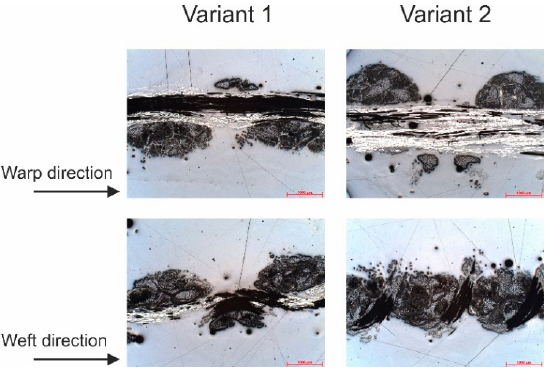
Figure 6. Microscopic images of the fabric’s cross-section in the warp and weft directions.